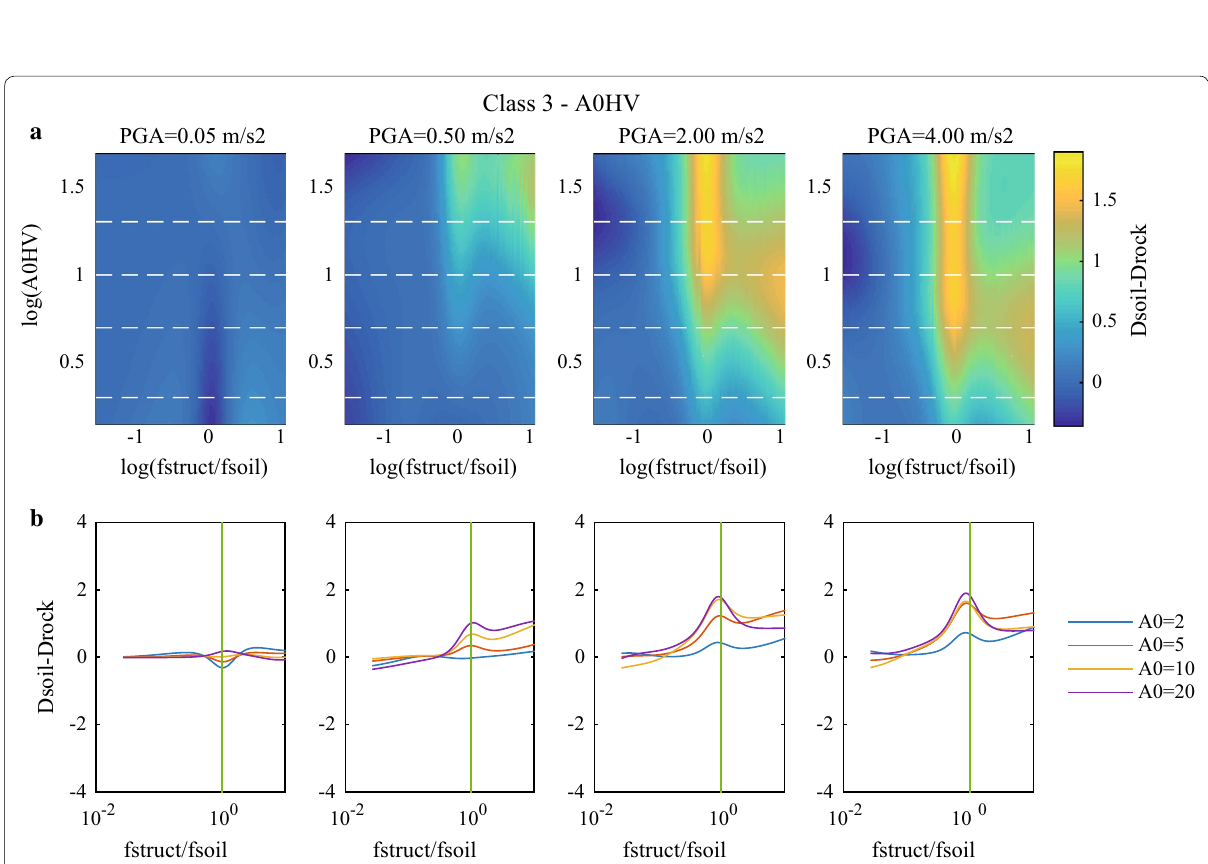
f 0t and A 0HV A 0t = =